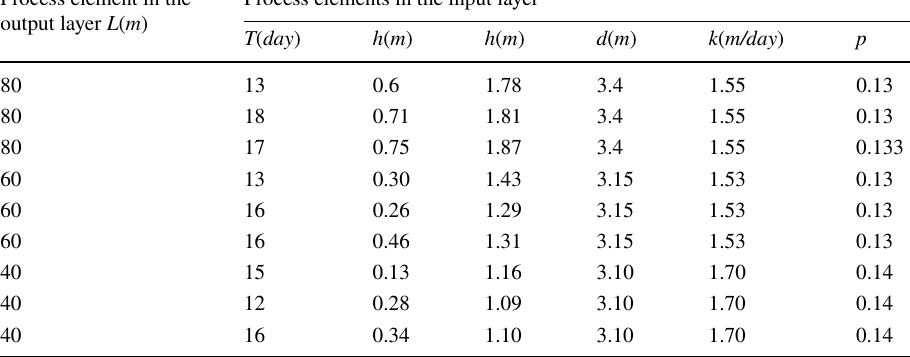
Table 3 Using neural networks application